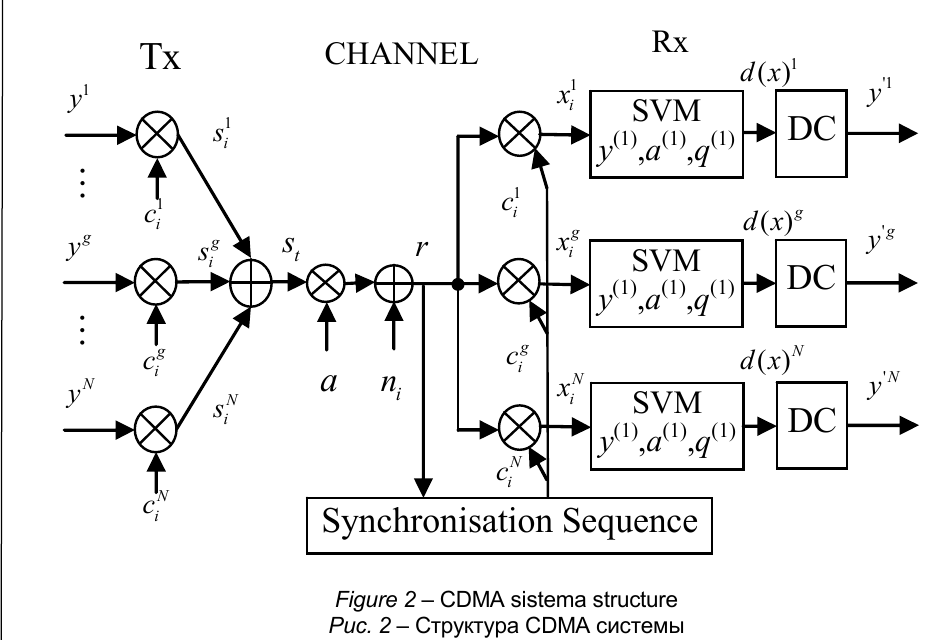
Figure 2 – CDMA sistema structure Рис . 2 – Структура CDMA системы Slika 2 – Struktura CDMA